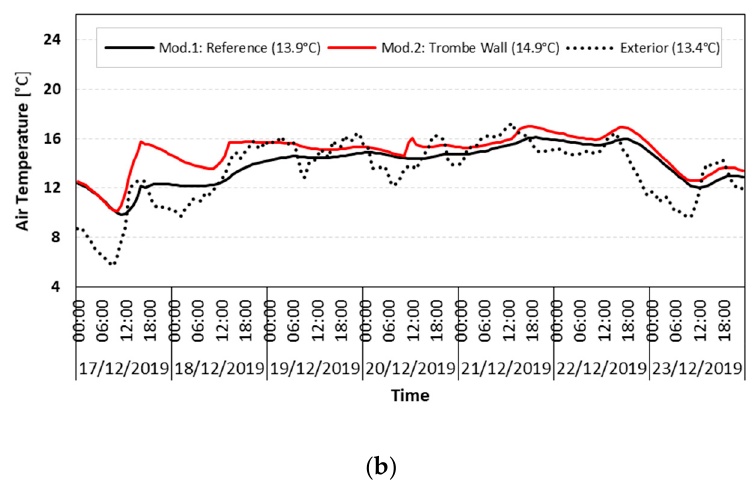
Figure 10. Recorded indoor air temperatures with and without a Trombe wall: ( a ) Winter sunny week; ( b ) Winter cloudy week.